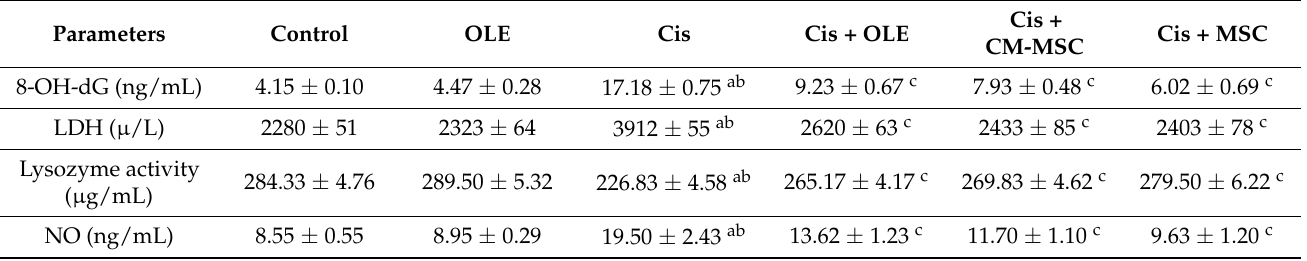
Table 6. Effects of olive leaf extract (OLE), mesenchymal stem cells (MSC), CM-MSC, cisplatin and their combination on 8-OH-dG, LDH, lysozyme activity and NO of